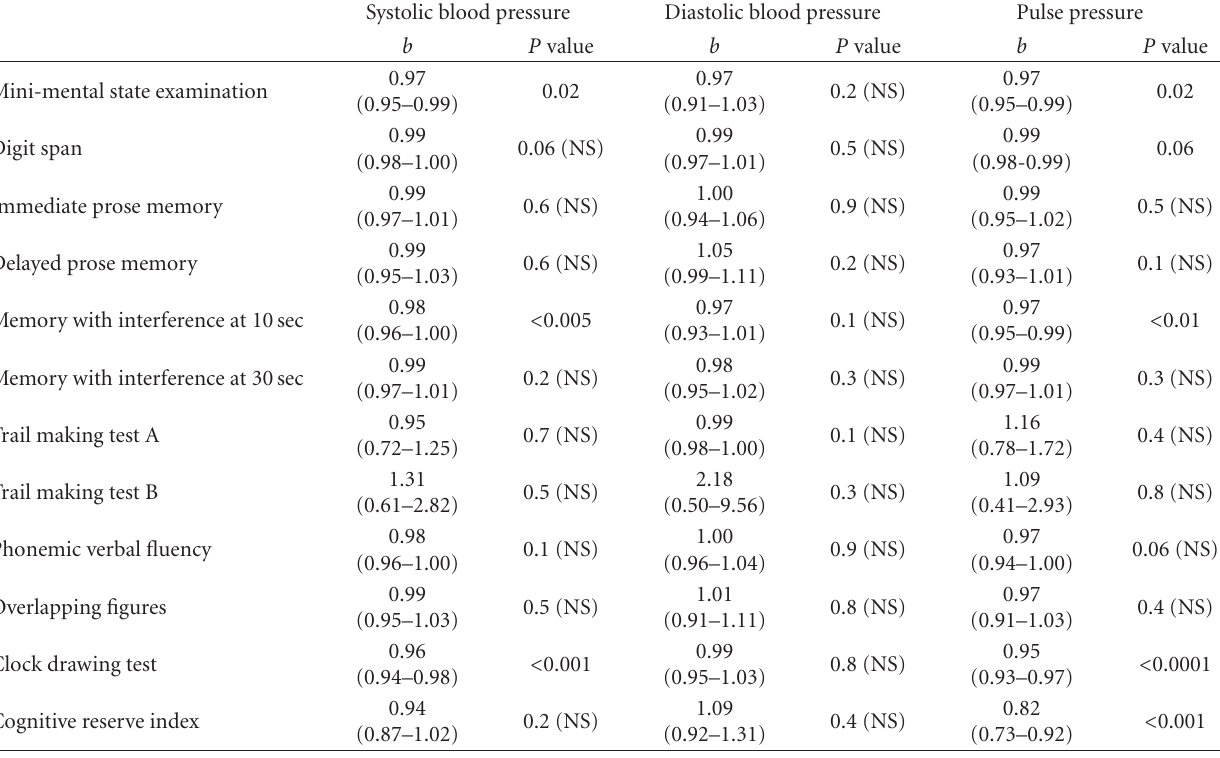
Table 4: Regression of the test scores with the systolic and diastolic components of blood pressure.